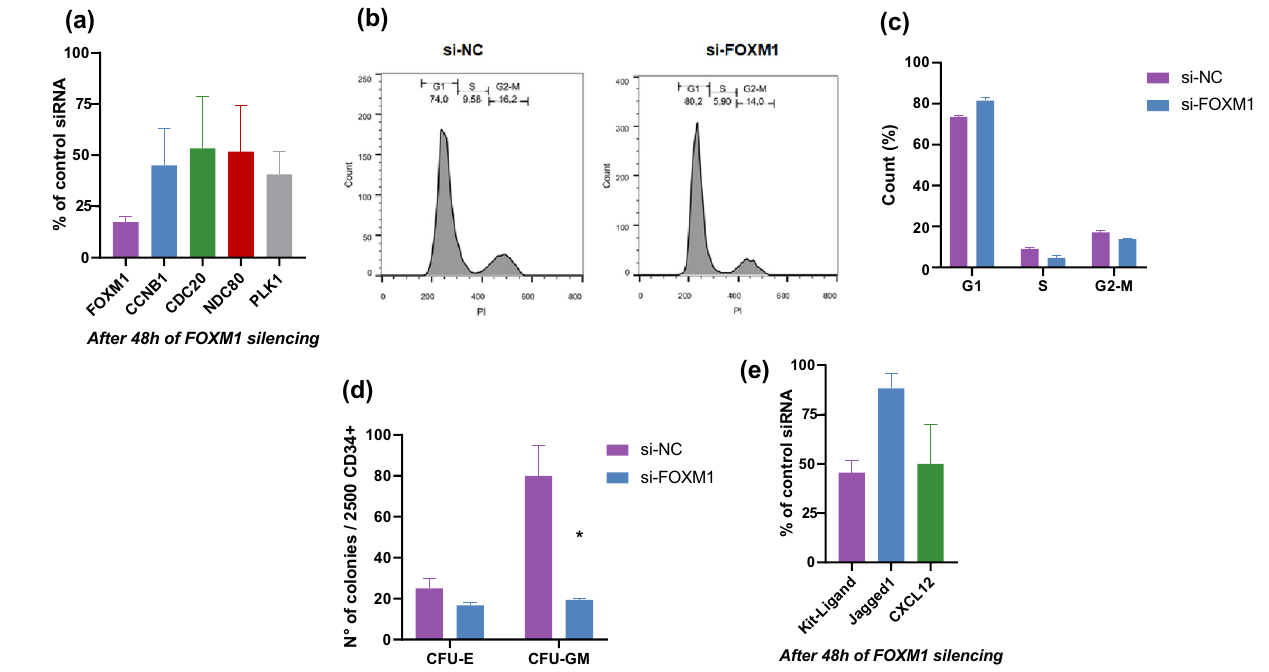
Figure 5. Effects of FOXM1 silencing ( A ) Expression levels of FOXM1 and of its mitotic targets ( CCNB1, CDC20, NDC80, PLK1 ) in MSC isolated from HD (n = 5), and cultured for 48 h in the presence of 1 µM si-FOXM1 1,2,3 RNA, as compared to treatment with control siRNA (si-NC). si-FOXM1: MSC transfected with a pool of 3 FOXM1 siRNA. ( B – C ) Cell cycle analysis of HD-MSC transfected with 1 µM si-FOXM1 1,2,3 RNA and cultured for 48 h. si-NC: MSC transfected with negative control siRNA; si-FOXM1: MSC transfected with a pool of 3 FOXM1 siRNA. ( D ) In vitro colony assays. A total of 2500 CD34 + cells isolated from healthy donors (HD) were co-cultured for 10 days with HD-MSC silenced for FOXM1, and then plated in a semisolid culture system for 10–12 days. Bar plots show the number of CFU-GM and CFU-E colonies. Data are represented as mean ± SD (* p ≤ 0.05) from 3 independent experiments. CFU-GM, colony forming unit—granulocytes, macrophages; si-NC: HD-CD34 + co-cultured with MSC transfected with negative control siRNA; si-FOXM1: HD-CD34 + co-cultured with MSC transfected with a pool of 3 FOXM1 siRNA. ( E ) Expression levels of several molecules involved in HSC interaction (KitL, Jagged1, CXCL12 in MSC isolated from HD (n = 5), and cultured for 48 h in the presence of 1 µM si-FOXM1 1,2,3 RNA, as compared to treatment with control siRNA (si-NC). si-FOXM1: MSC transfected with a pool of 3 FOXM1